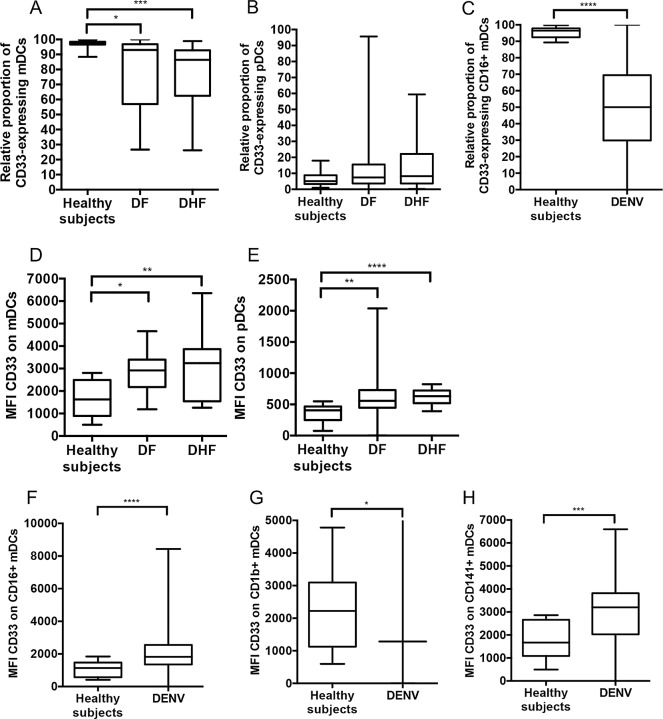
Comparison of the relative proportion and MFI of CD33-expressing mDCs and pDCs during acute DENV infection.The relative proportion of CD33-expressing mDCs (A) and pDCs (B) were compared between three groups, healthy subjects, DF and DHF patients. The relative proportion of CD33-expressing CD16+ mDCs in DENV-infected patients were compared with healthy individuals (C). The MFI of CD33 on mDCs (D), pDCs (E), CD16+ mDCs (F), CD1b+ mDCs (G), CD141+ mDCs (H) were compared between healthy subjects and DENV-infected patients. The box plot shows the median value (horizontal line in the box). The box and whisker represent 25th to 75th, and 10th to 90th interquartile range, respectively. P values were determined by the Dunn’s post-test after Kruskal-Wallis test for comparison of three groups or Mann-Whitney U test for comparison between two groups. (* p < 0.05, ** p < 0.01, *** p < 0.001 and **** p < 0.0001).